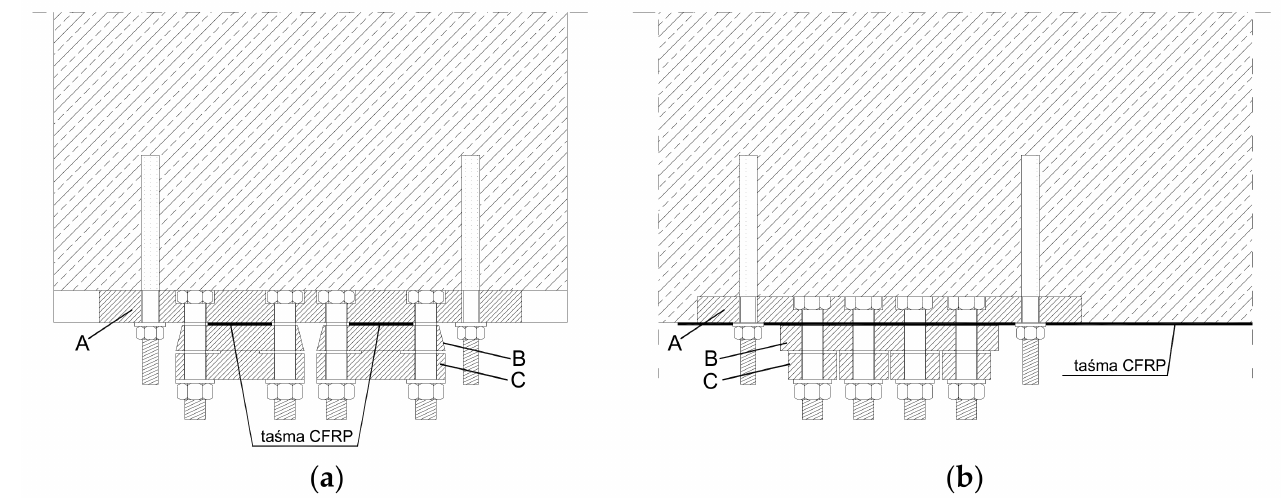
Figure 3. ( a ) Transverse and ( b ) longitudinal cross-section of fixed anchor for two tendons.